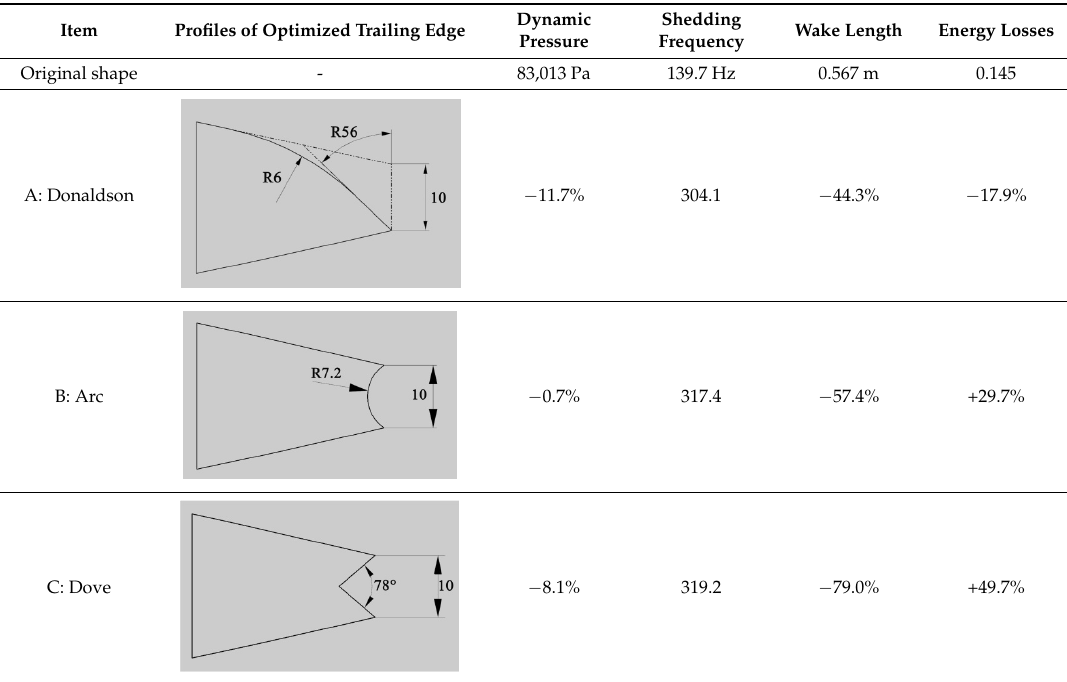
Table 5. The comparison of optimized geometries.